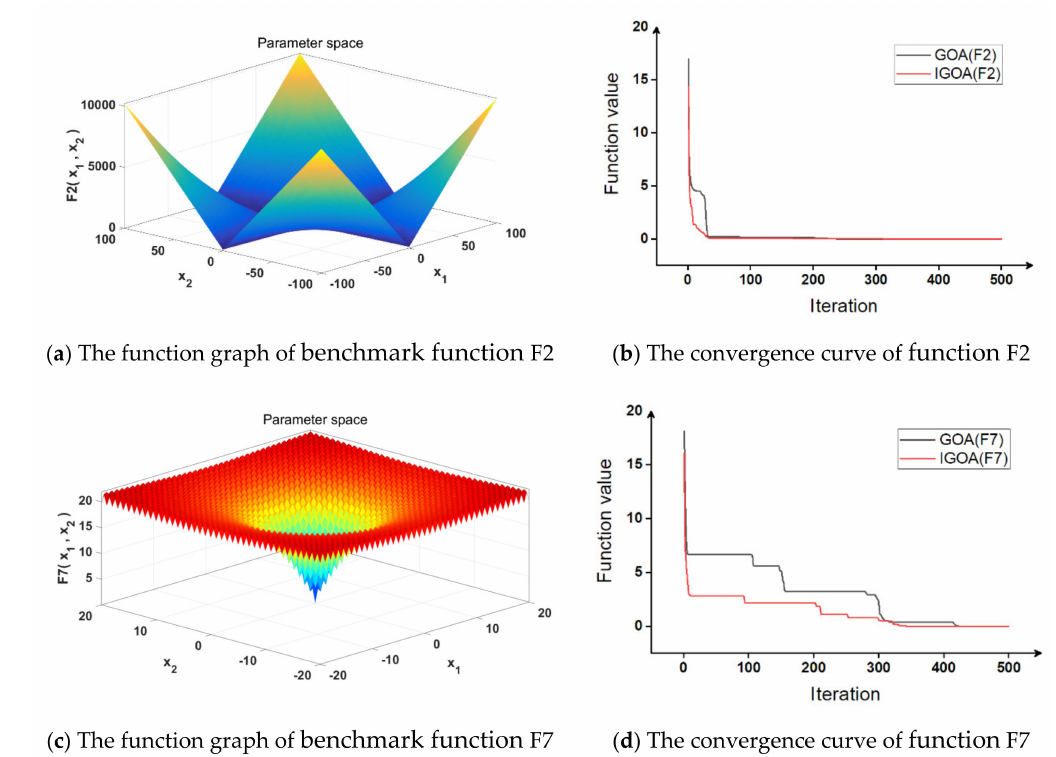
Figure 3. The performance comparison of improved grasshopper optimization algorithm (IGOA) and GOA on benchmark functions (F2 and